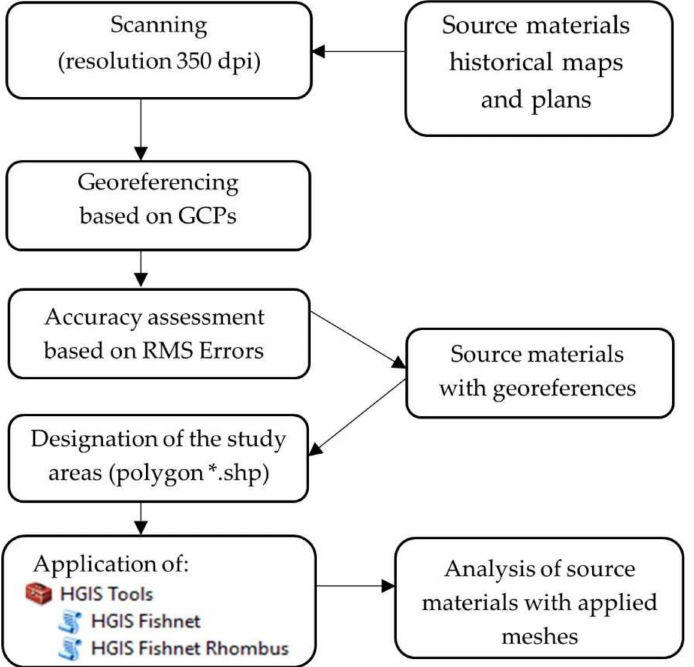
Figure 6. Schematic workflow of preparation of historical cartographic materials for analysis with the use of HGIS